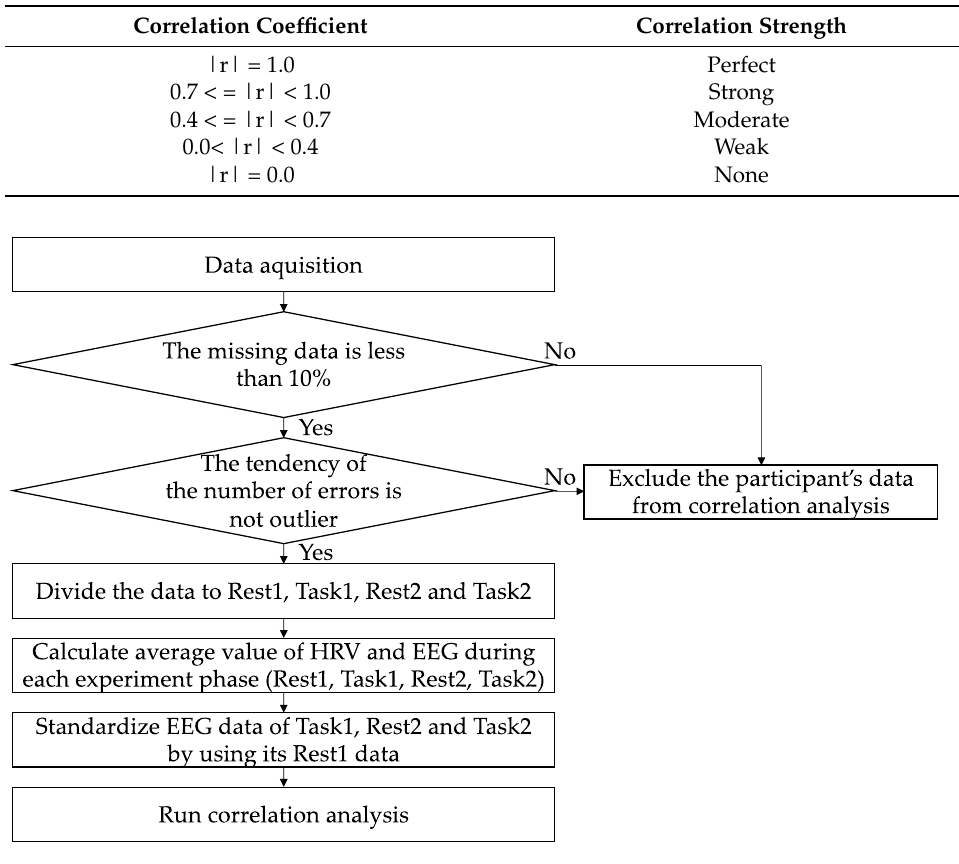
Table 4. Correlation coefficients and related correlation strength [67].